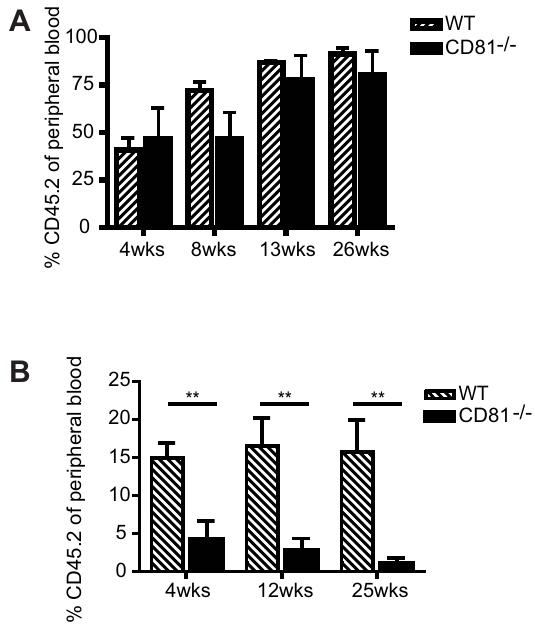
Figure 2. CD81 is essential for maintaining HSC self-renewal . (A) Cd81 2 / 2 HSCs show comparable engraftment capacity in primary competitive transplantation assays, in which 300 HSCs (CD45.2 + SP KLS ) were transplanted with 2.2 6 10 5 wild-type (WT) competitors (CD45.1) into lethally irradiated mice (CD45.1 + ). Peripheral blood engraftment was measured at the indicated time points. Mean values 6 50 are shown ( n =3). (B) Cd81 2 / 2 HSCs showed only minimal levels of engraftment in secondary competitive transplantation assays, in which 300 donor-derived HSCs (CD45.2 + SP KLS ) were purified from the primary recipients 21 wk after primary transplantation and transplanted along with 2 6 10 5 wild-type competitors into lethally irradiated mice. Mean values 6 SD are shown ( n =10, ** p , 0.01).